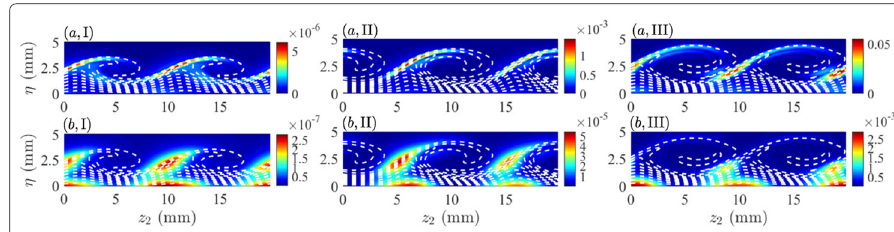
Fig. 19 The evolution of u 2,rms ( a , I-III) and p rms ( b , I-III) in the wall-normal planes at x = 200 mm (I), 230 mm (II) and 260 mm (III) during the breakdown of stationary crossflow vortices in a high-speed swept wing boundary layer (Chen et al.: Stationary cross-flow breakdown in a high-speed swept-wing boundary layer, submitted). The dashed lines represent the temporal mean of the vortex-axial oriented velocity u